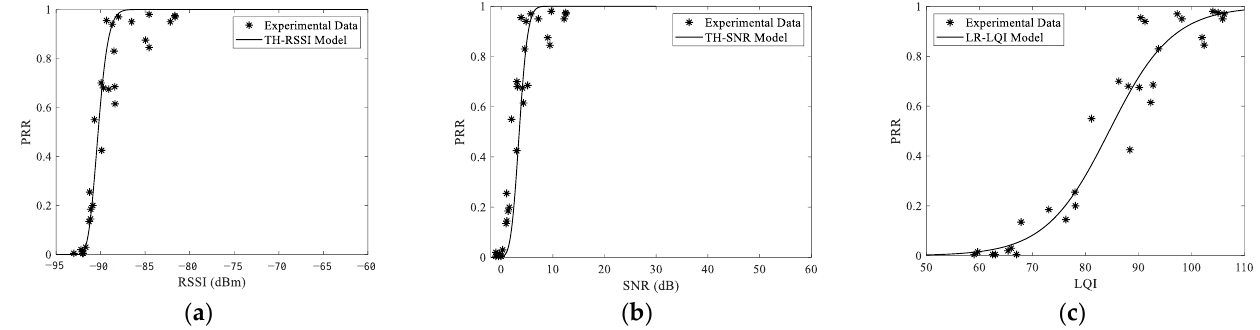
Figure 13. Typical link quality metrics and models with the 5.8 GHz UAV: ( a ) RSSI and its theoretical model with PRR, ( b ) SNR and its theoretical model with PRR, ( c ) LQI and its logistic regression model with PRR.